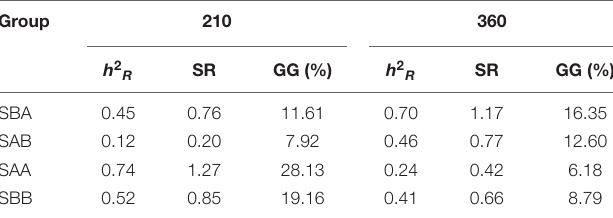
TABLE 6 | Realized heritability (h R 2 ), standardized response to selection (SR), and current genetic gain (GG) of selected groups of P.